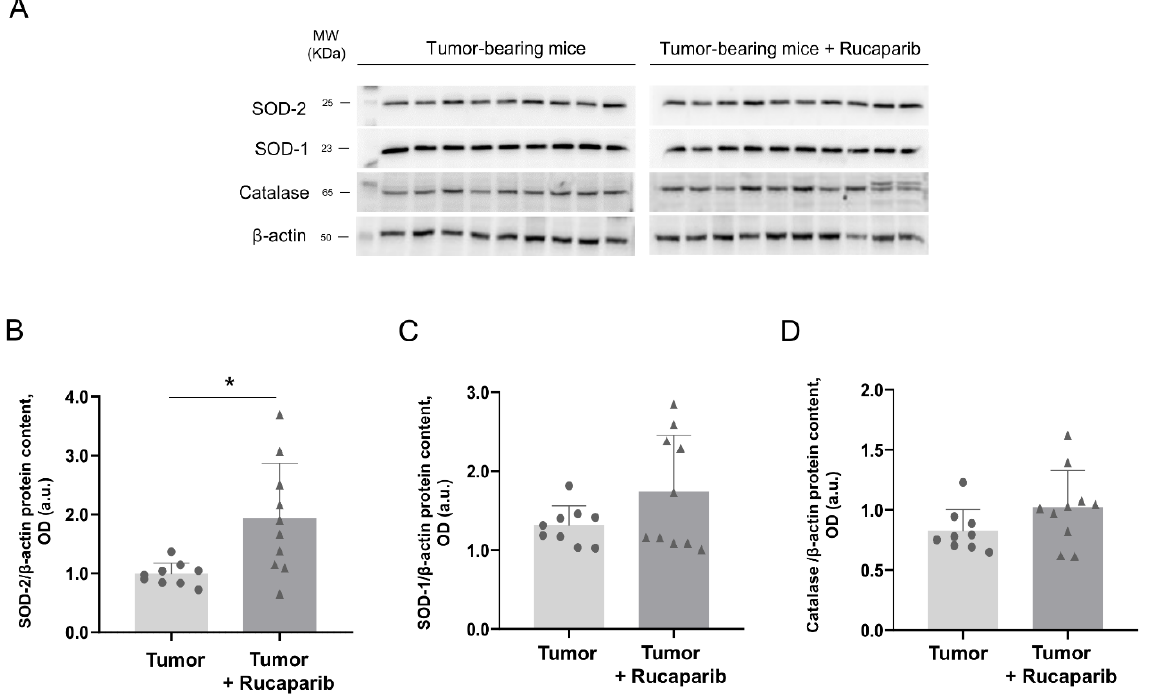
Figure 7. Representative immunoblots of SOD-1, SOD-2, catalase and β -actin proteins in the tumors of both study groups ( A ). Mean values and standard deviations of SOD-1 ( B ), SOD-2 ( C ) and catalase ( D ) protein content. In the scatter plot, the circles represent the untreated tumor-bearing mice while the triangles represent the rucaparib treated tumor-bearing mice. Statistical significance: * p ≤ 0.05 between tumor-bearing mice treated with rucaparib and non-treated tumor-bearing mice. Definition of abbreviations: SOD, superoxide dismutase; OD, optical densities; a.u., arbitrary units.